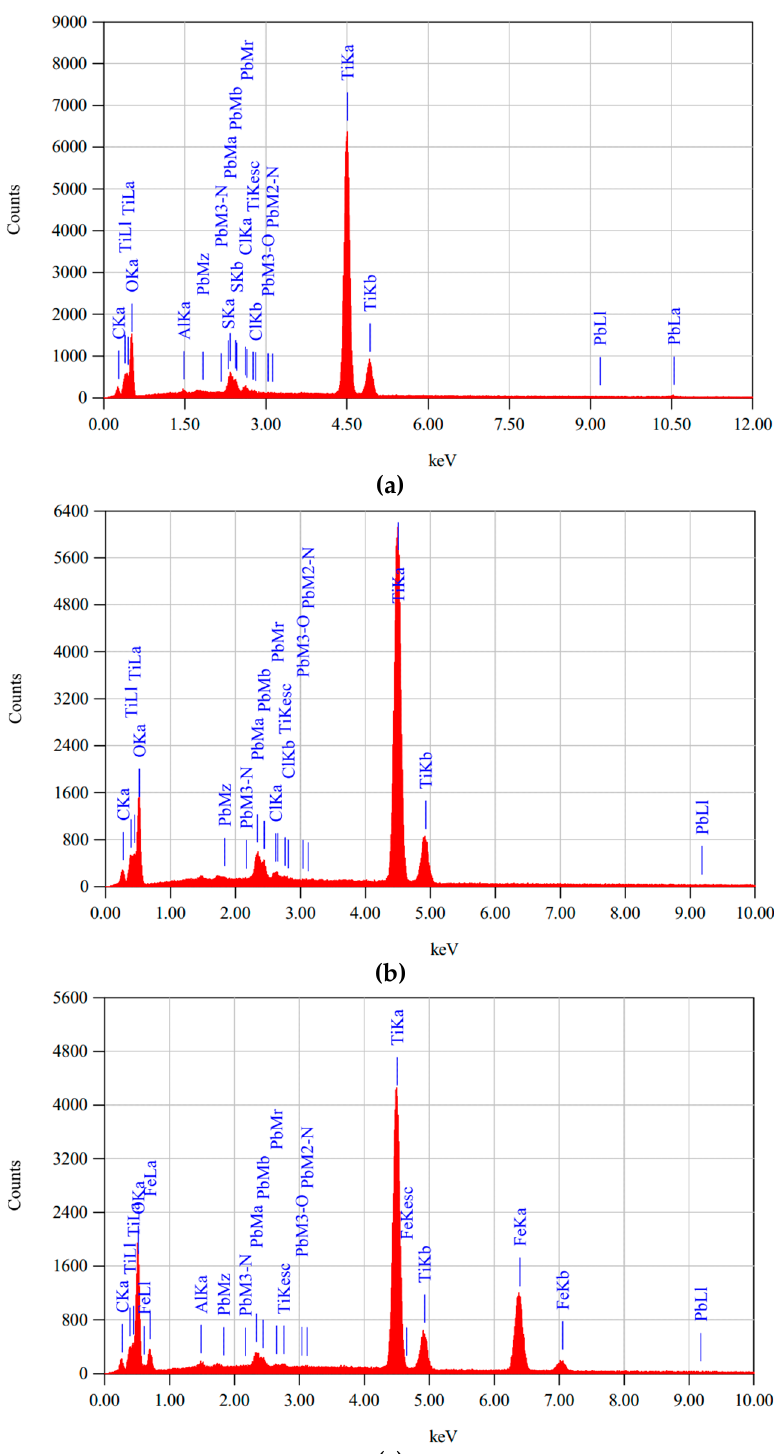
Figure 2. SEM images of ( a ) TiO 2 , ( b ) Fe 3 O 4 , ( c ) C-doped TiO 2 , and ( d ) C-doped TiO 2 /Fe 3 O 4 nanocomposites.